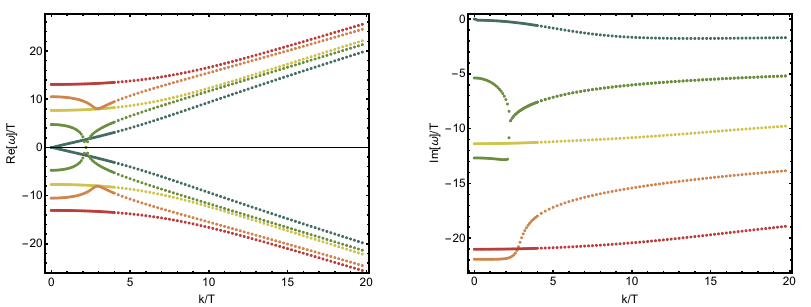
Figure 9 . The longitudinal spectrum of the (cid:13)uid model V ( Z ) = Z for m=T = 0 : 773. frequency and momentum dynamics for a speci(cid:12)c value of the EXB. Several gapped and strongly damped modes appear in the spectrum producing a very non trivial interplay of collisions and crossovers. Let us notice that at large k=T (cid:29) 1 all the modes obey Re( ! ) = k which is simply dictated by the relativistic symmetry of the UV (cid:12)xed